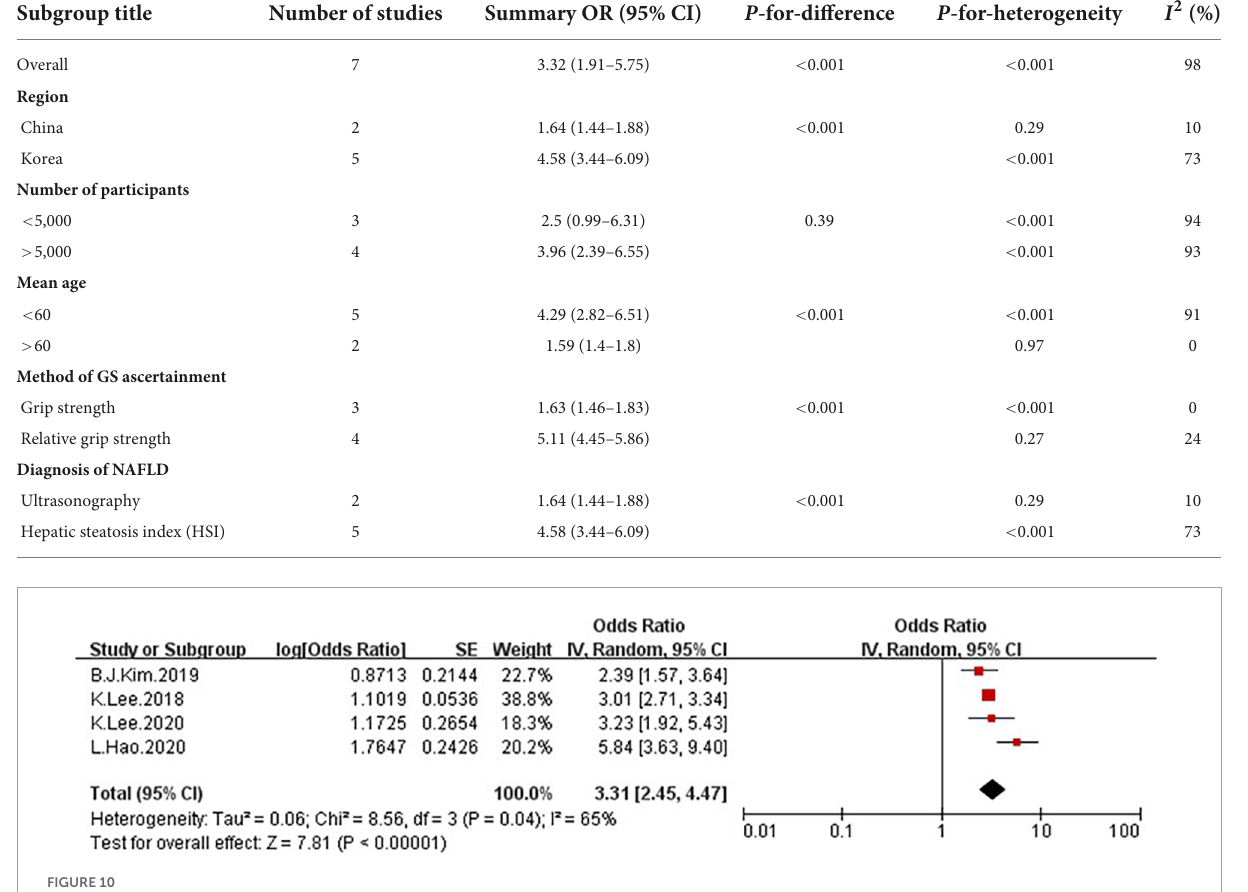
TABLE 2 Subgroup analysis of low grip strength and the risk of NAFLD.